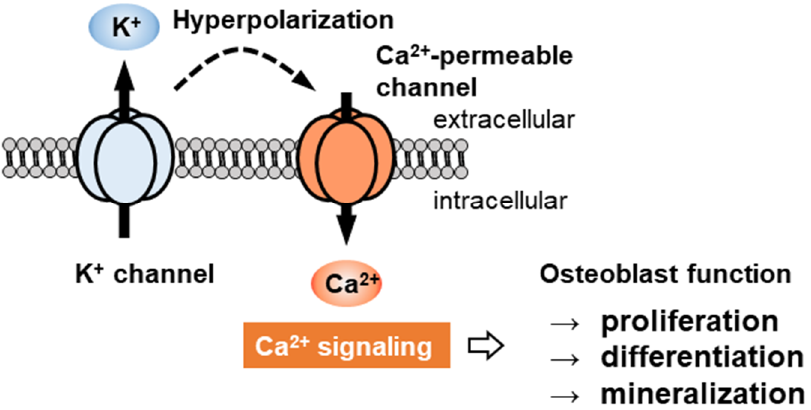
Figure 2. In non-excitable cells, voltage-independent Ca 2+ channels are the main Ca 2+ -permeable channels. Membrane hyperpolarization followed by K + channel activation increases the driving force for Ca 2+ influx. Consequently, K + channels indirectly regulate osteoblast functions, including prolif- eration, differentiation, and mineralization, by controlling intracellular Ca 2+ signaling in osteoblast lineage